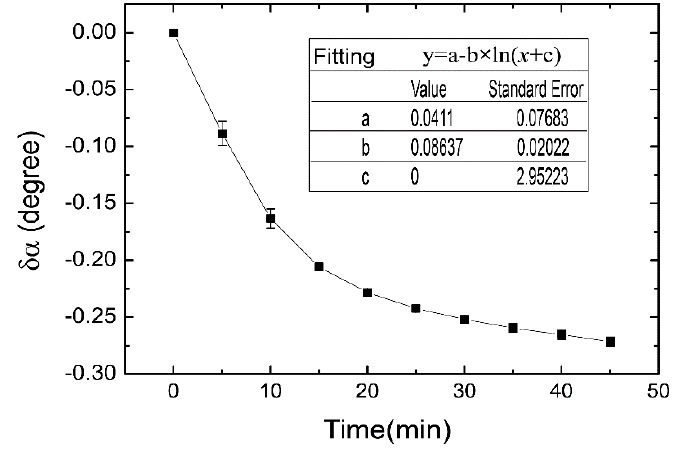
Figure 10. Optical rotation detection for the sucrose hydrolysis with commercial polarimeter. The error bar was obtained with three